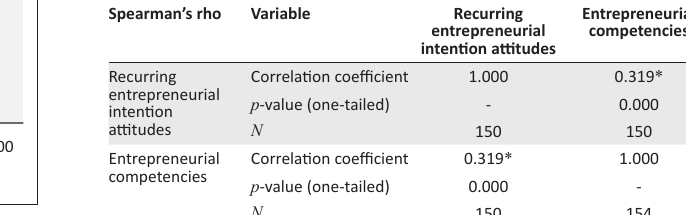
FIG URE 7: Scatter plot showing the relationship between recurring entrepreneurial intention attitudes and entrepreneurial competencies.